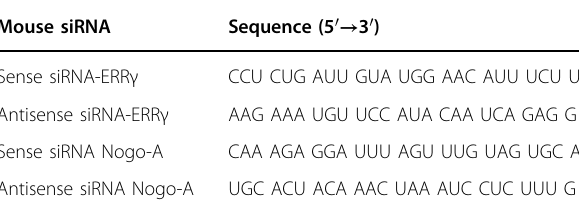
Table 2 Sequences of